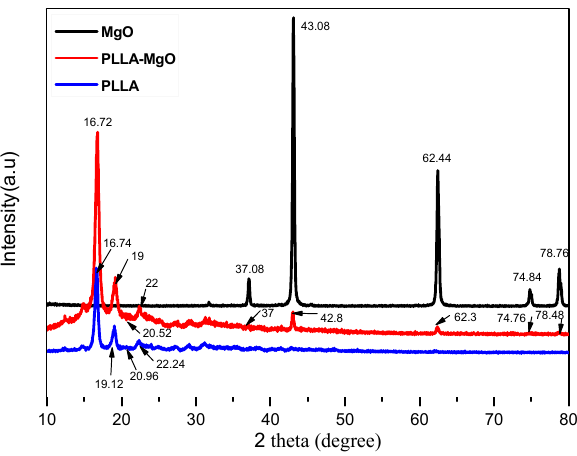
Figure 2. The X-ray diffraction pattern of MgO, PLLA, and PLLA1 composites.